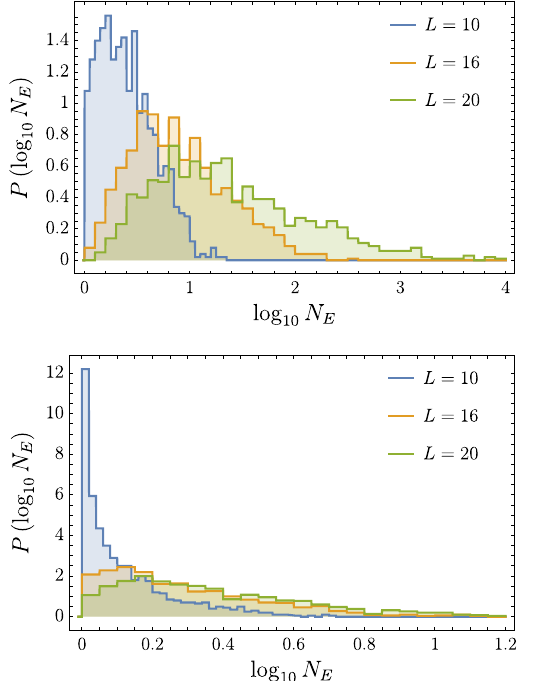
for α ¼ 1 (upper) and α ¼ 0 . 3 E